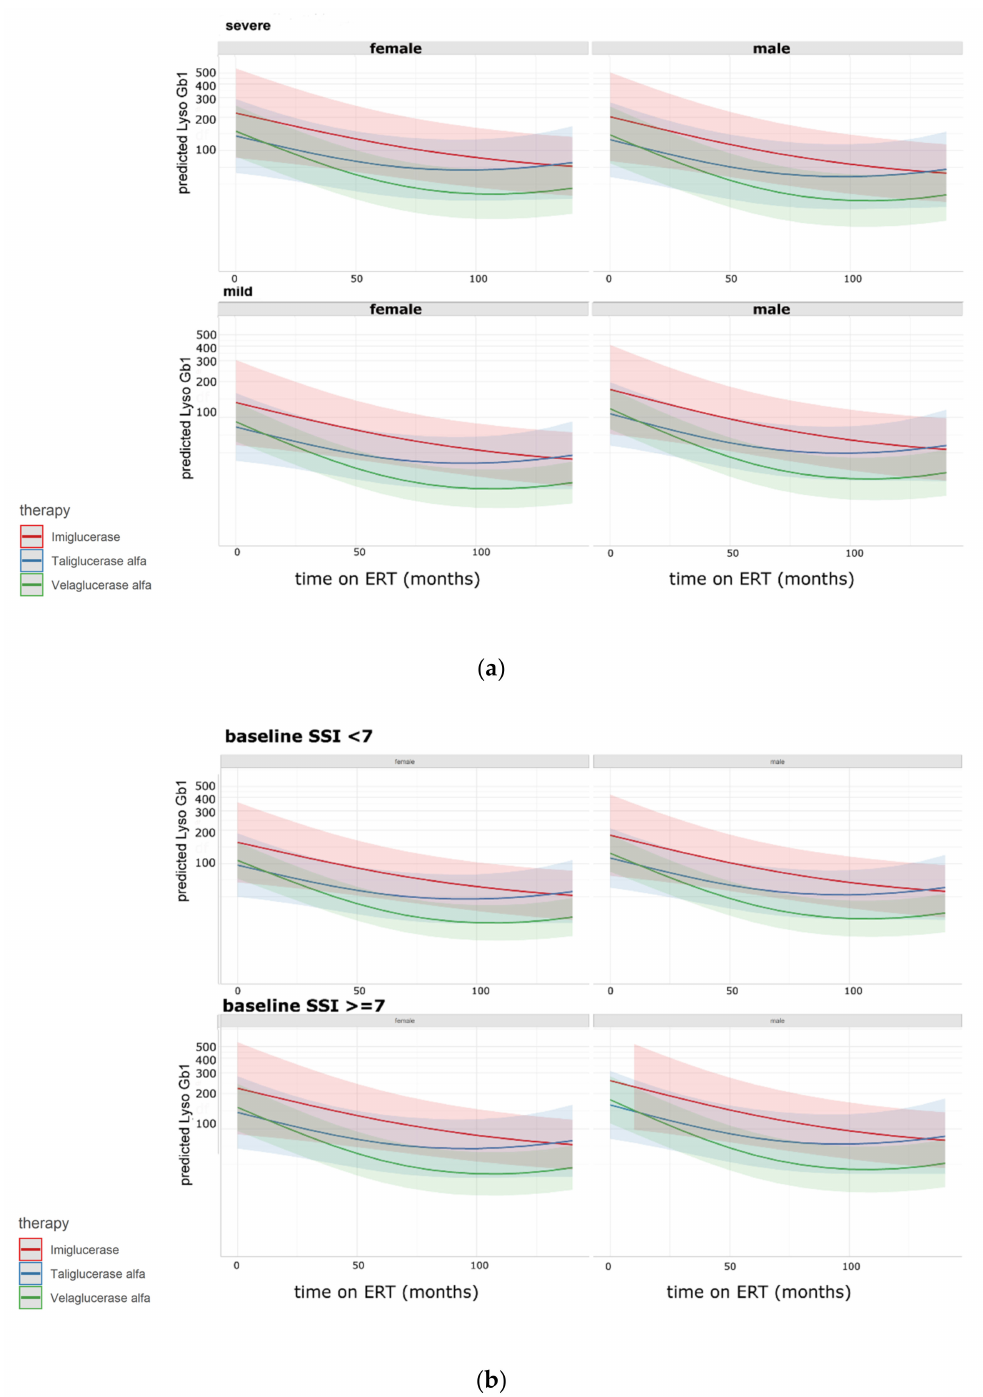
Figure 2. Model-based values for lyso-Gb1 by severity (( a ) according to genotype, ( b ) according to severity score index (SSI)), enzyme replacement therapy (ERT) and sex. Model: a linear mixed model with a random intercept for individuals (135 individuals, 617 measures). Dependent variable: lyso-Gb1 log-transformed. Independent variables: age at the first visit, sex, ERT (Imiglucerase, Taliglucerase alfa, Velaglucerase alfa), SSI at baseline categorized (cut off 7), dosage, severity according to genotype, time on ERT. Time on ERT and type of ERT were entered as an interaction term and using natural cubic splines for the time on ERT with two degrees of